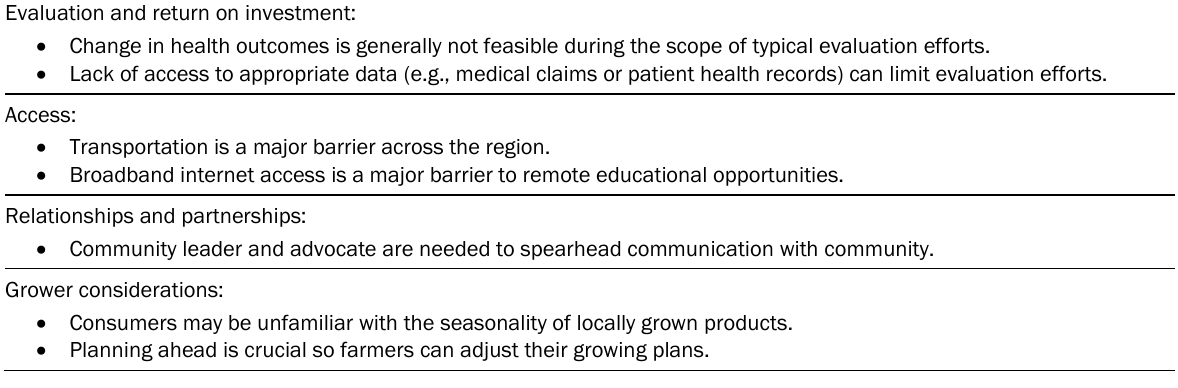
Table 2. Additional Challenges and Considerations Evaluation and return on